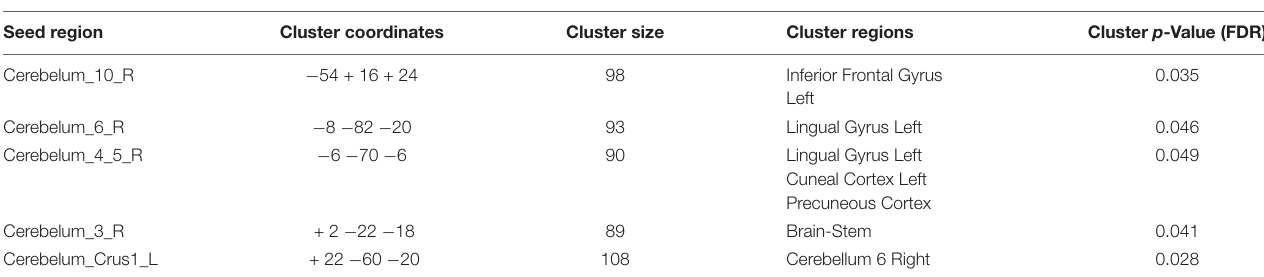
TABLE 3 | Seed regions with reduced functional connectivity in TLE vs.